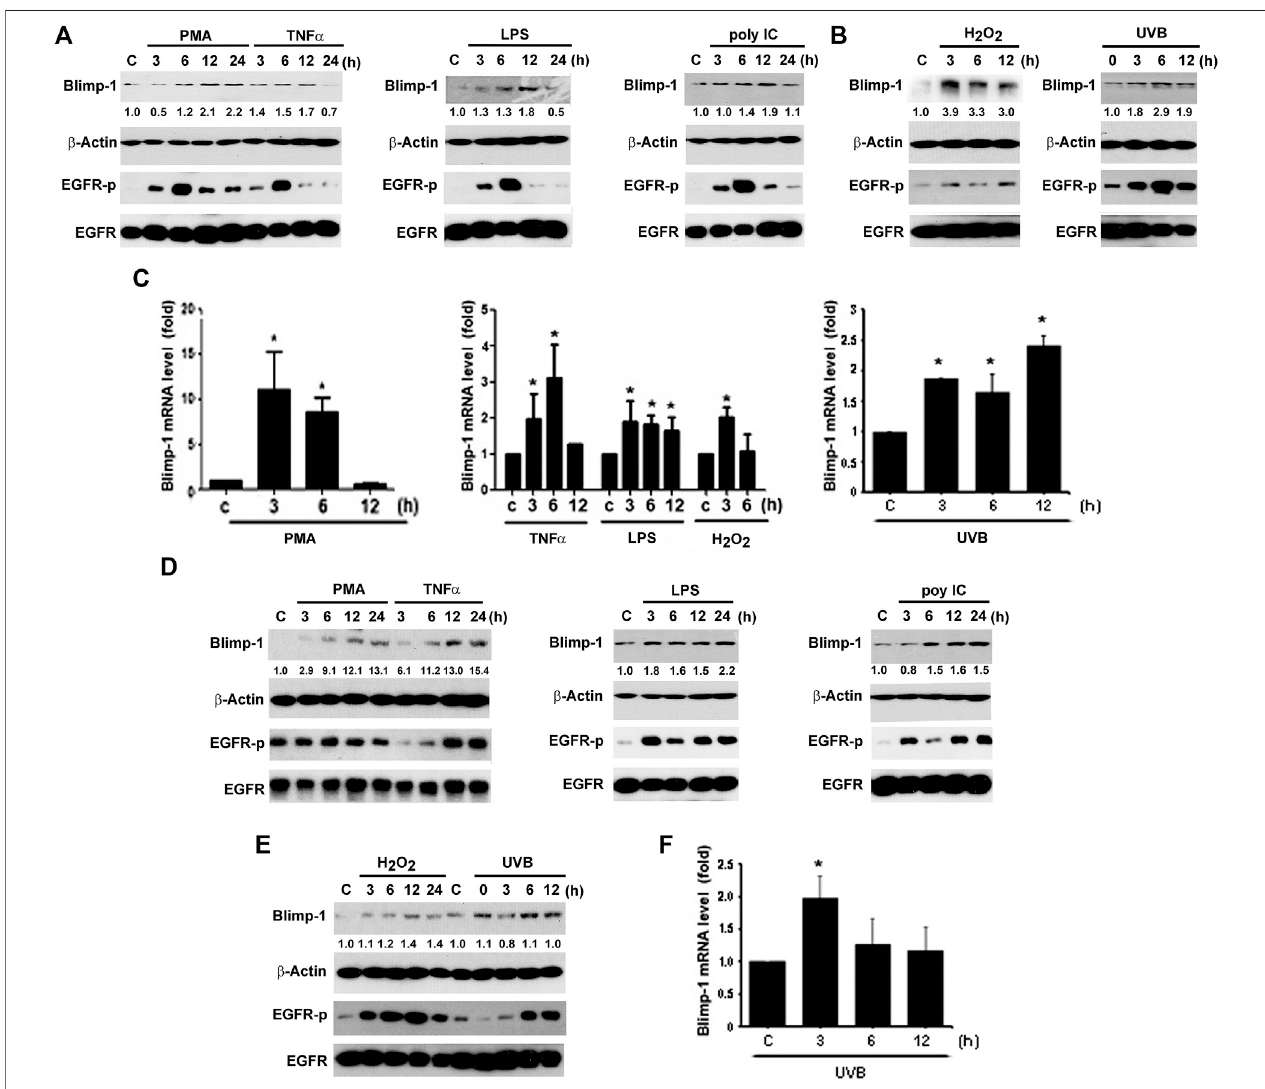
FIGURE 2 | Blimp-1 expression was induced by various stimuli in Cal-27 and SAS cells. Cal-27 cells (A – C) and SAS cells (D – F) were treated with PMA (30 nM), TNF- α (10 ng/ml), LPS (1 μ g/ml), polyIC (50 μ g/ml), H 2 O 2 (200 μ M) or UVB (50 mJ/cm 2 ) for indicated times. Protein expression ofBlimp-1 and β -actin were analyzed by immunoblotting (A,B,D,E) . Q-PCR was performed to evaluate the mRNA level of Blimp-1 (C,F) . * p < 0.05 (mean ± S.E.M., n = 3) as compared to control group.